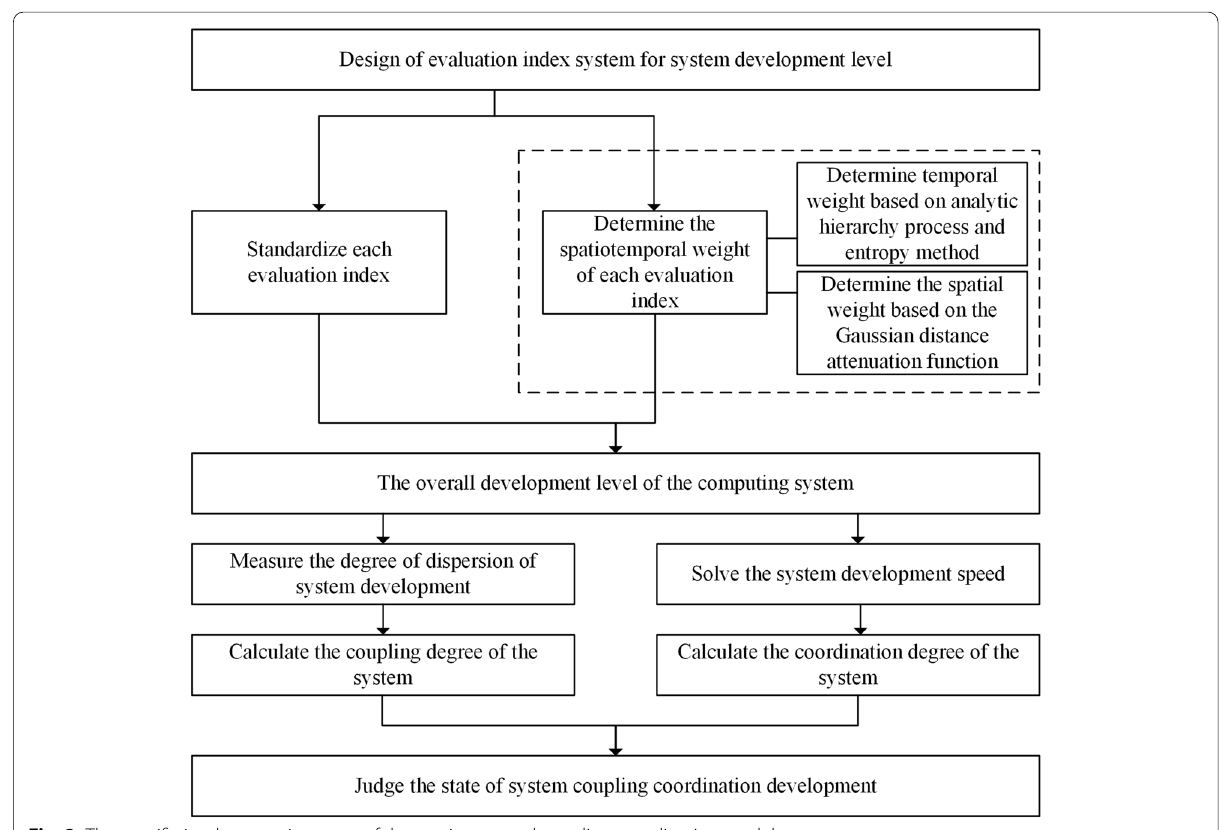
Fig. 2 The specific implementation steps of the spatiotemporal coupling coordination